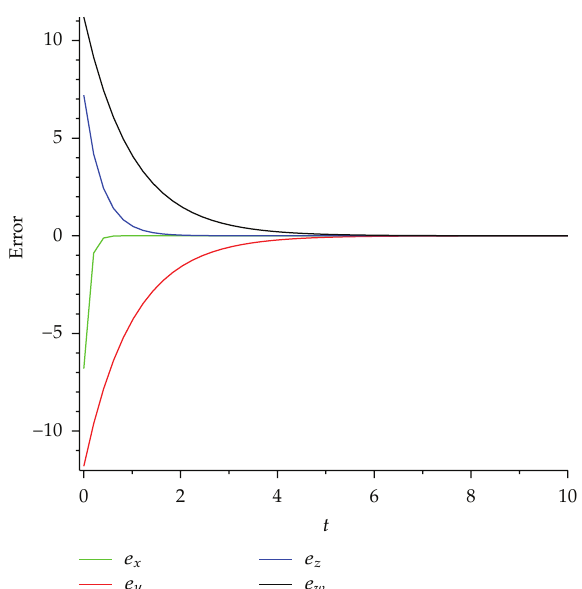
Figure 11: It shows the behaviour of the trajectories e x ,e y ,e z , and e w of the error system between hyperchaotic Lorenz system and hyperchaotic L¨u system tends to zero as t tends to 5 when the scaling factor α (cid:8) −